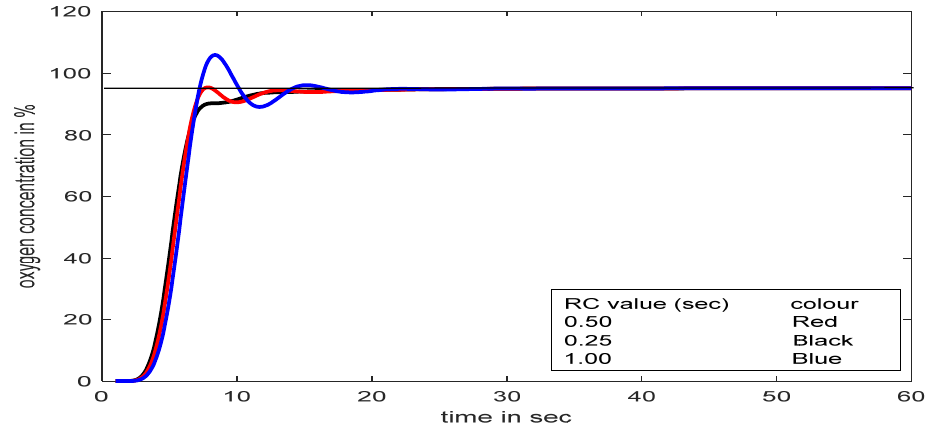
Figure 14. Comparative studies of different time constants of oxygen cylinder model with the proposed controller.